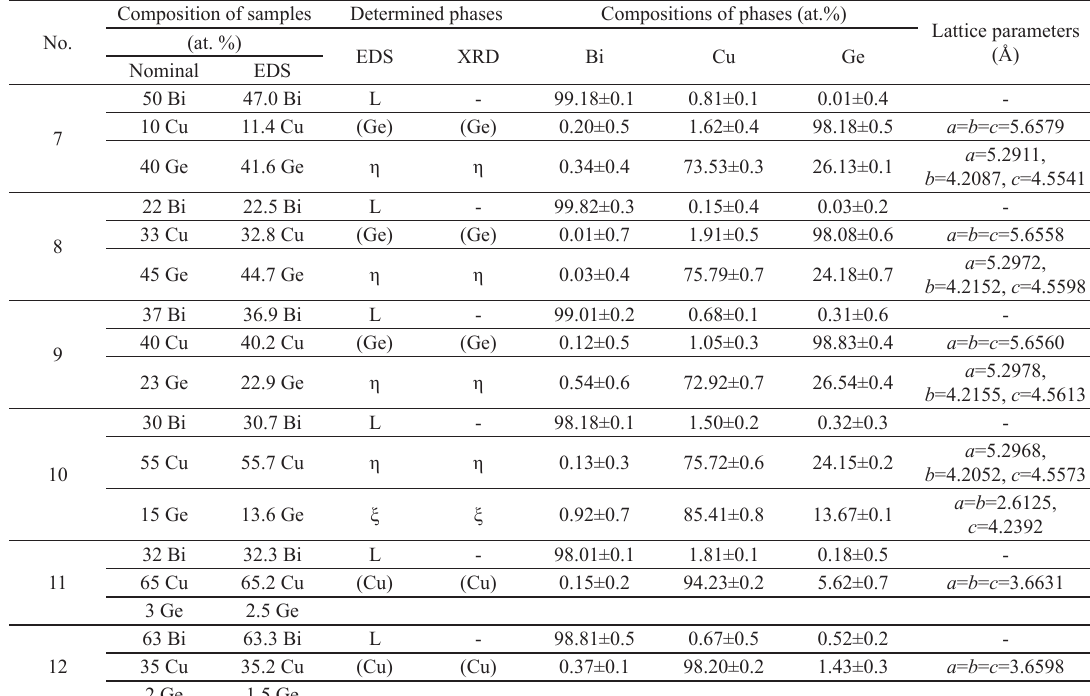
Table 3. Combined results of SEM-EDS and XRD analyzes of the selected Bi-Cu-Ge alloys annealed at T=400 °C. Composition of samples No.